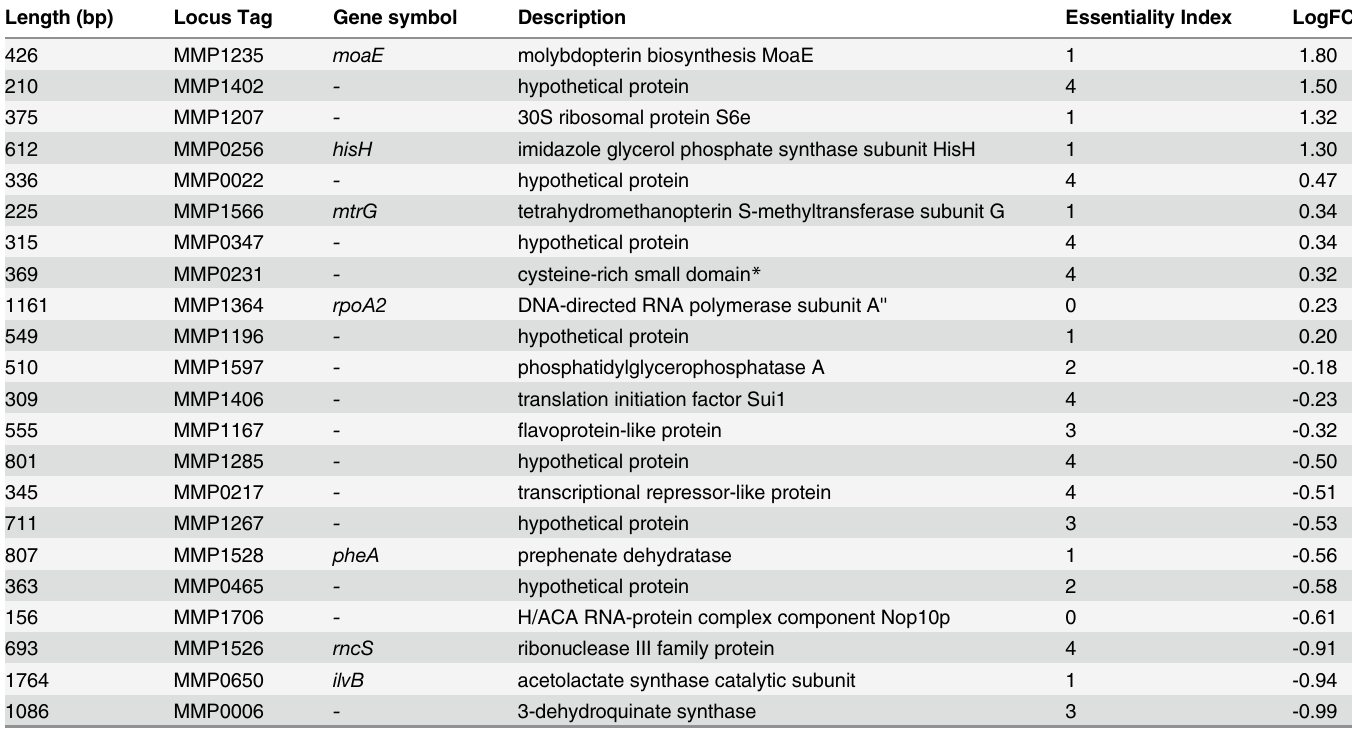
Table 1. Genes with EI < 5 (essential according to Tn-seq Explorer) but with LogFC > -1.0 (that is, strongly non-essential according to the ESSEN- TIALS results) Length (bp)